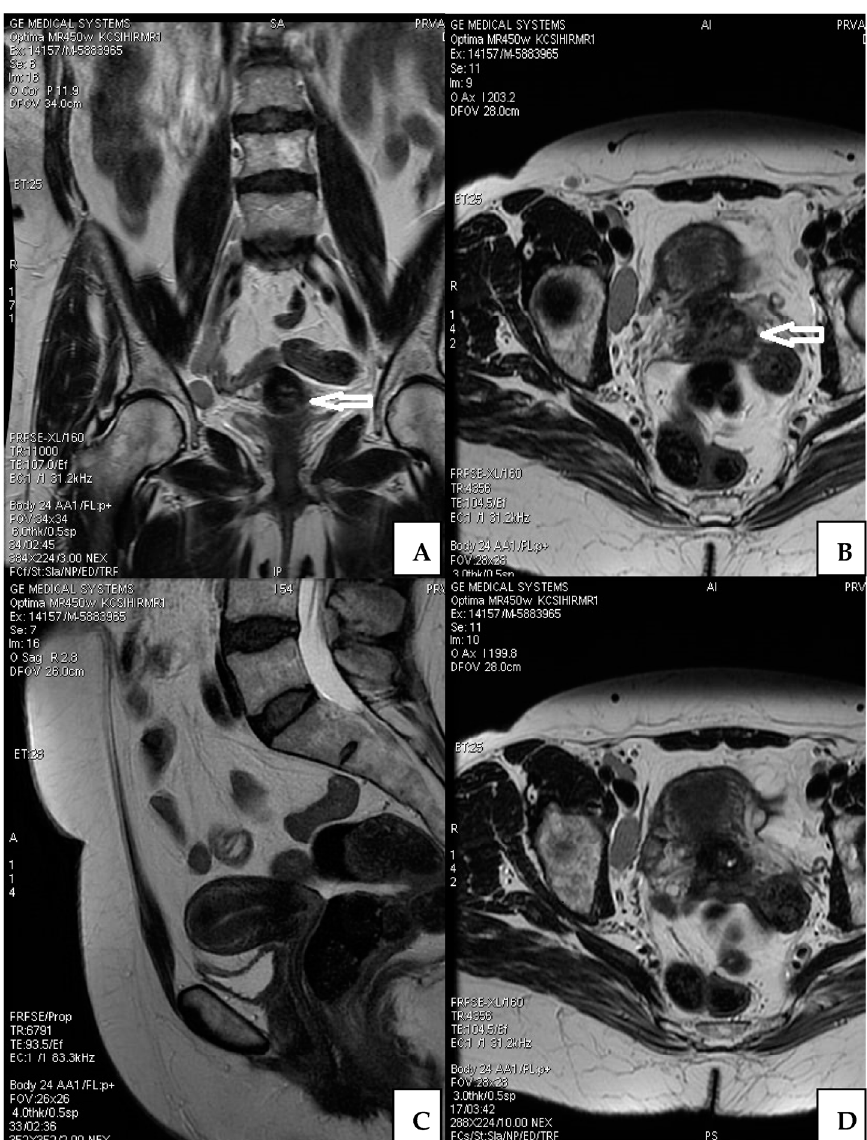
Figure 1. MRI of the abdomen and pelvis after conization. Cervical lesion (arrow) on diferent imaging presentations ( A , B ); Endometrium without detected tumor lesions ( C ); Adnexa without tumor lesion ( D ).